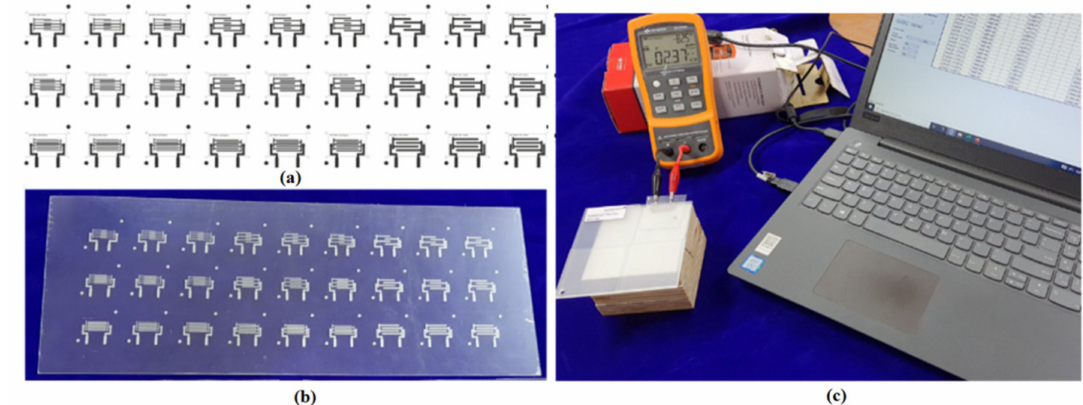
Figure 10. Design to Performance stage ( a ) Design of pattern ( b ) Fabricated sensors pattern ( c ) Change in capacitance measurement while